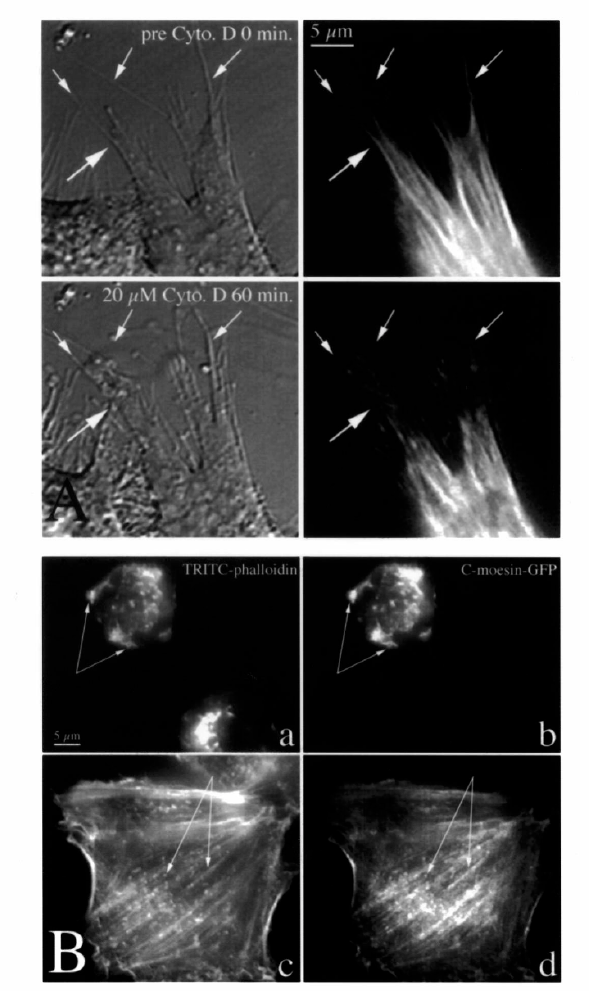
Figure 6 C-moesin-GFP does not interfere with microfilament rear- rangements during and after treatment with cytochalasin D. In (A), a transfected cell was imaged live by DIC (left) and C- moesin-GFP fluorescence (right) during treatment with cyto- chalasin D. The large arrow points at changes within one pseudopodium. The small arrows point to filopodia and retraction fibers. Note withdrawal and clumping of C- moesin-GFP fluorescence. In (B), cells were treated for 30 minutes with 20 µ M cytochalasin D (a, b) and then fixed, or treated for 20 minutes and then allowed to recover for 1 hour after drug washout (c, d) before fixation. They were then stained with TRITC-phalloidin (a, c) and imaged for C- moesin-GFP fluorescence (b, d). Arrows point to identical spots in parallel